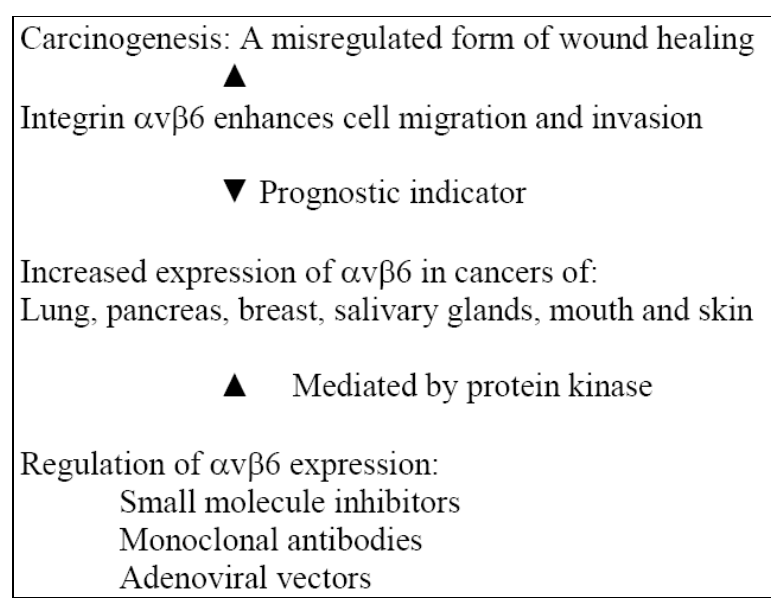
Figure 3. Integrin  v  6 and its interactions in